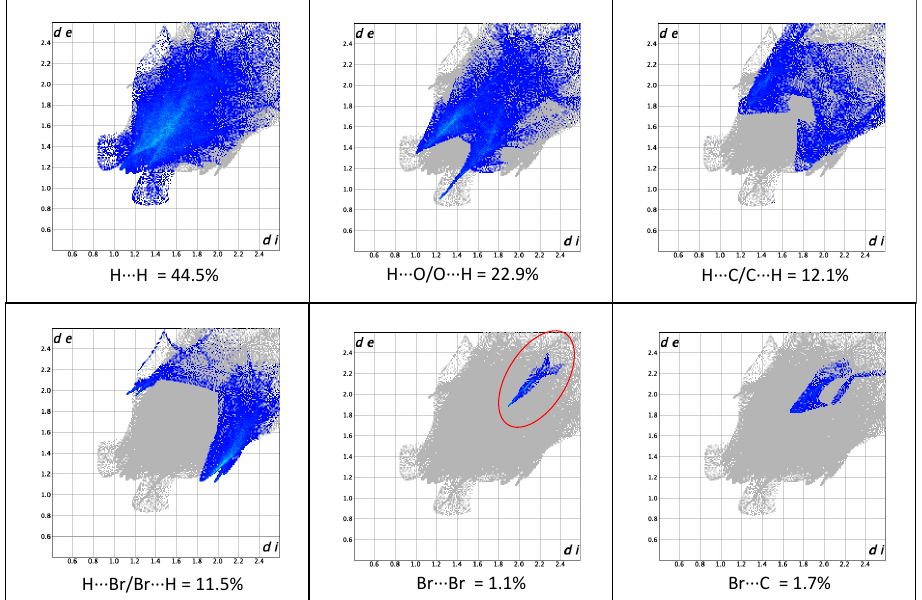
Figure 8. Fingerprint plots for 1b , delineated into H···H, O···H/H···O, C···H/H···C, Br···H/H···Br, Br···Br and Br···C contacts.